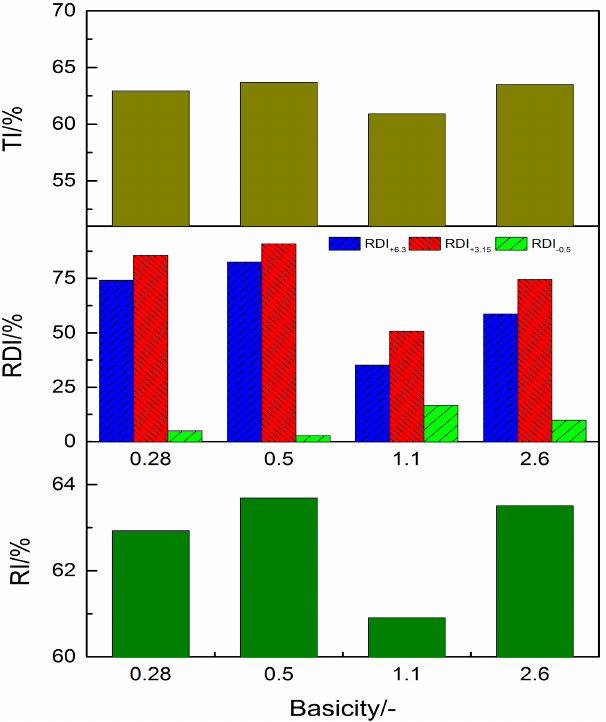
Figure 10. Metallurgical performance of acid, self-fluxing, and high-basicity PVTM sinters.